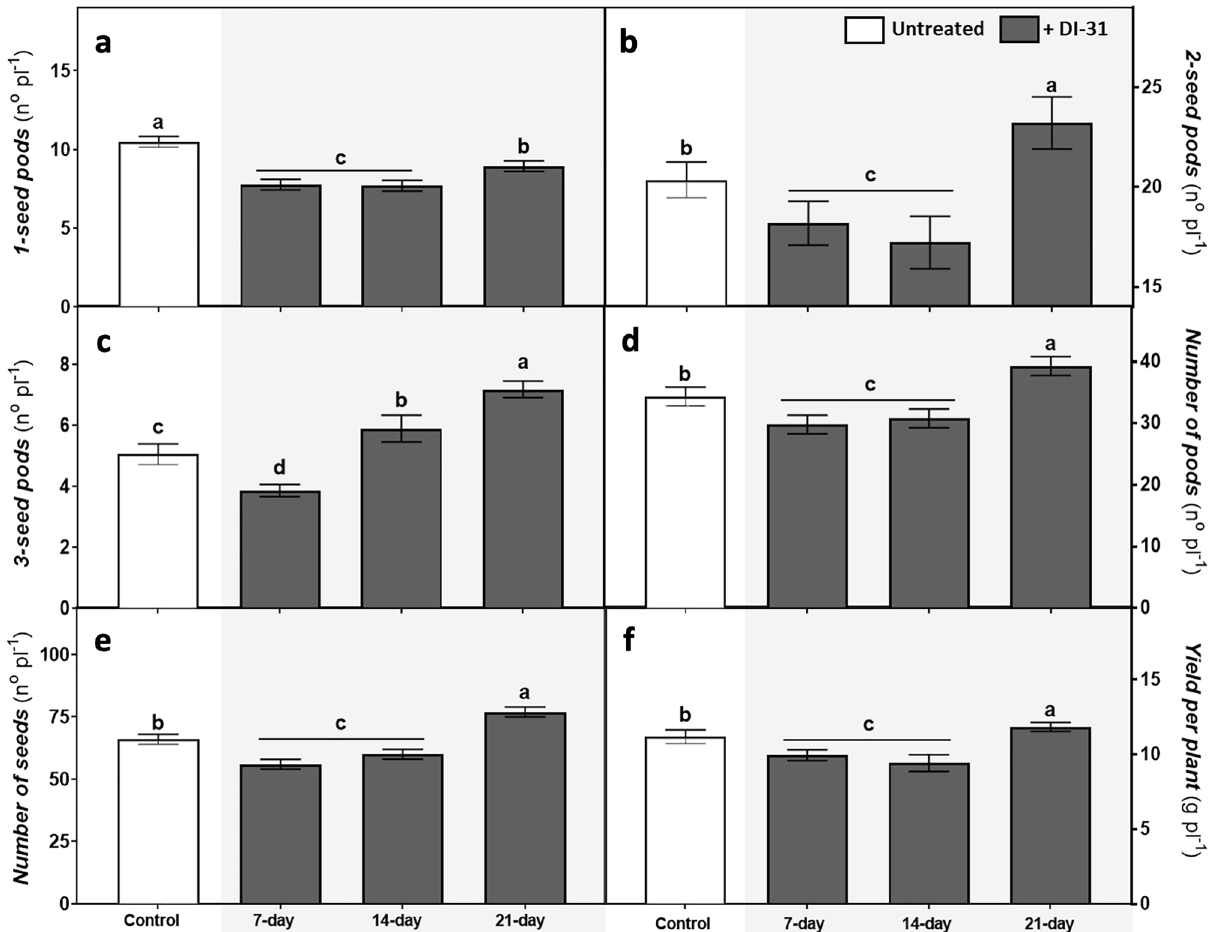
Figure 6. Effect of DI-31 (2.23 µM) foliar applications frequencies in soybean absolute yield and yield components. Parameters such as ( a ) number of pods with one seed per plant, ( b ) two seeds per plant, ( c ) three seeds per plant, ( d ) total pods per plant, ( e ) total seeds per plant and ( f ) absolute yield per plant were measured in cv Munasqa plants sprayed with DI-31 (2.23 µM; 1 mg/L) every 7, 14 or 21 days. Colour bars indicate control plants (white) or DI-31 treated ones (grey). Data are presented in means ± s.e.m of one independent experiment (n = 100). Different letters indicate significant differences (P ≤ 0.05) ANOVA with post hoc contrasts by Tukey’s